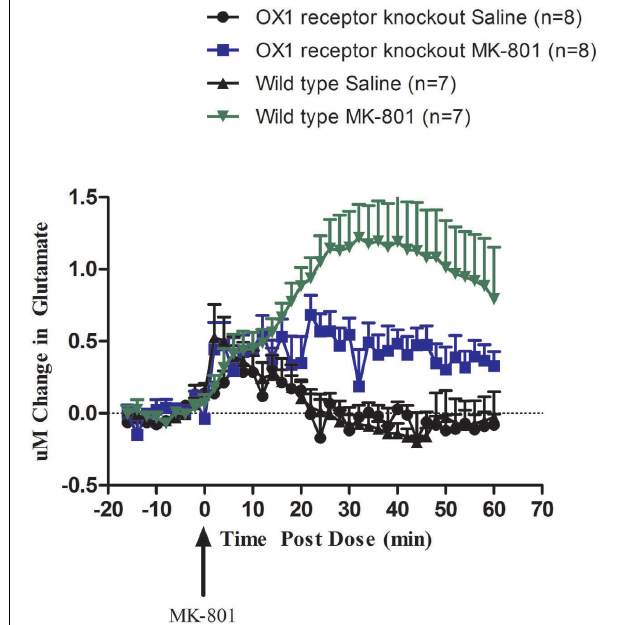
FIGURE 2 | Effect of MK-801 (0.178mg/kg, S.C.) on glutamate release in the cortex of freely moving OX1 receptor knockout mice and wild-type mice (within subject study design). Real-time measurements of glutamate were conducted before and after compound administration (MK-801 was administered at t = 0). Results are expressed as change in glutamate concentrations as mean ± s.e.m. MK-801 response in OX1 receptor knockout mice was attenuated compared to wild-type mice ( p = 0 .